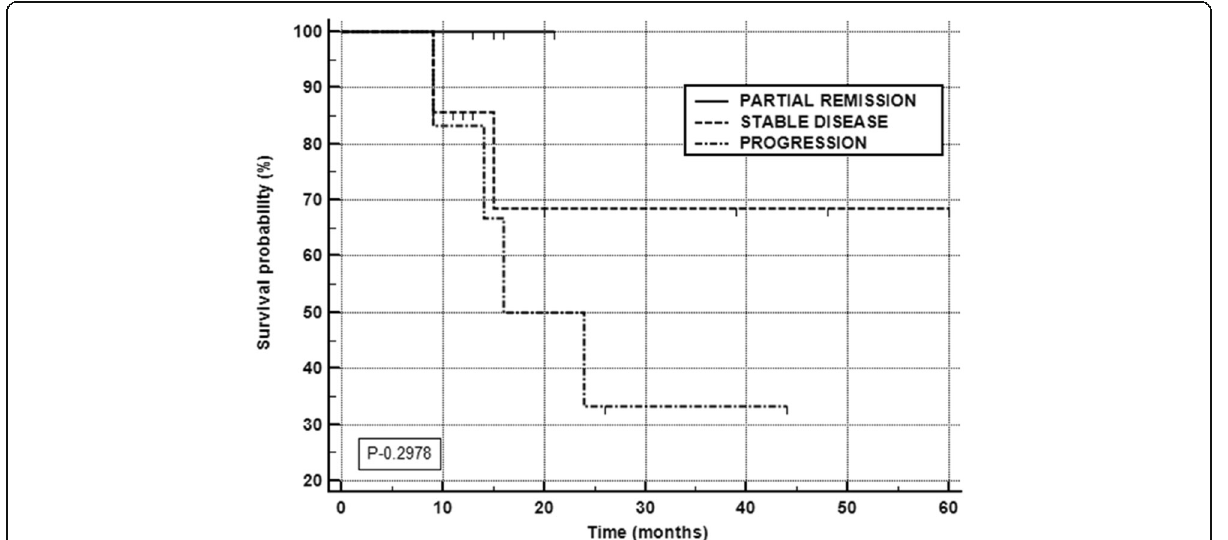
Fig. 3 Overall survival according to morphological response (RECIST 1.1 criteria)